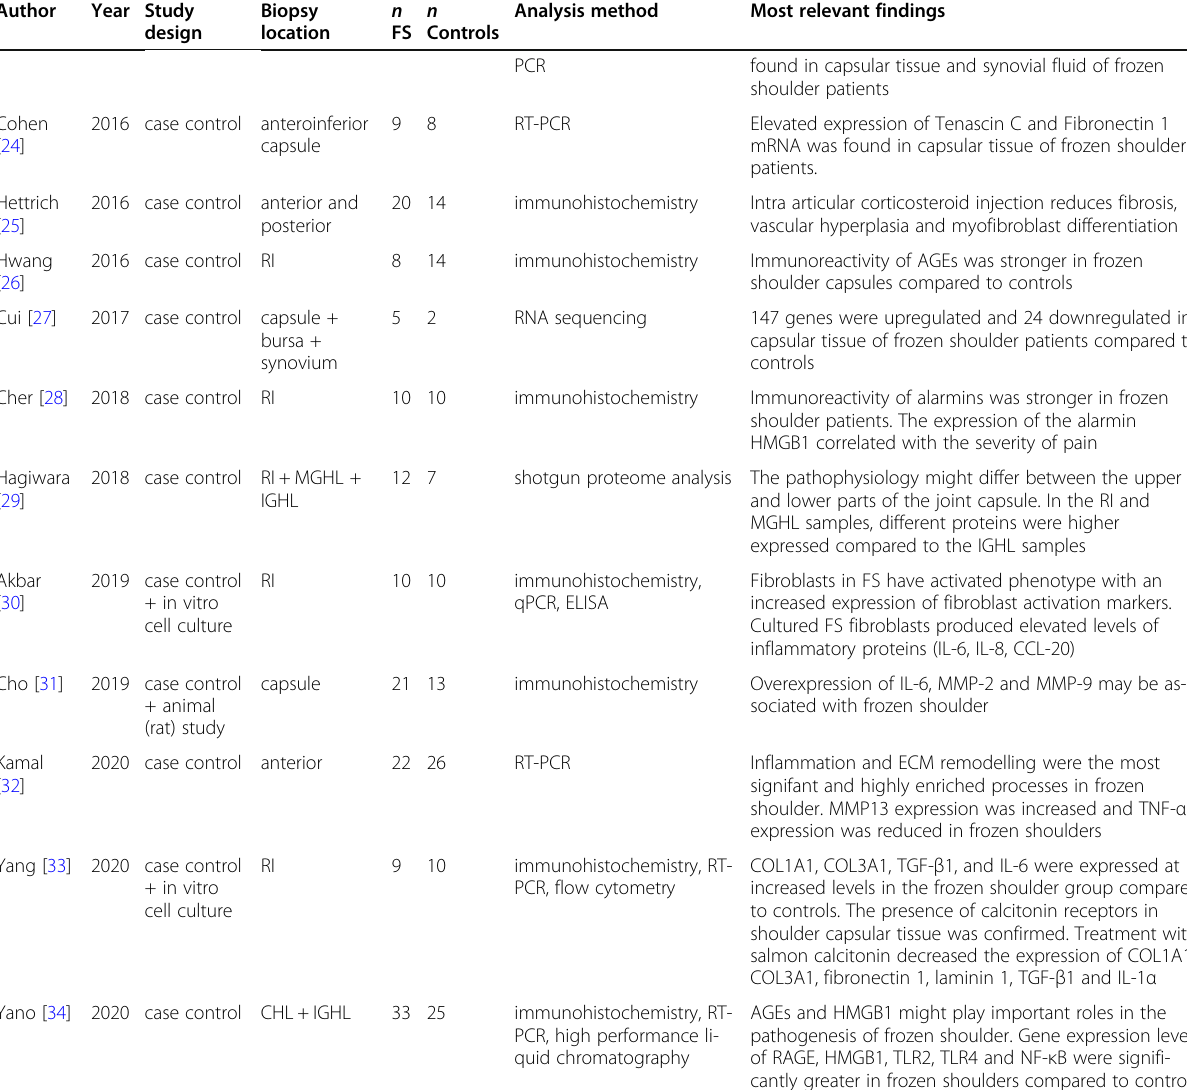
Table 1 Biopsy studies; studies investigating the pathophysiology of frozen shoulder with glenohumeral capsular tissue samples (Continued) Author